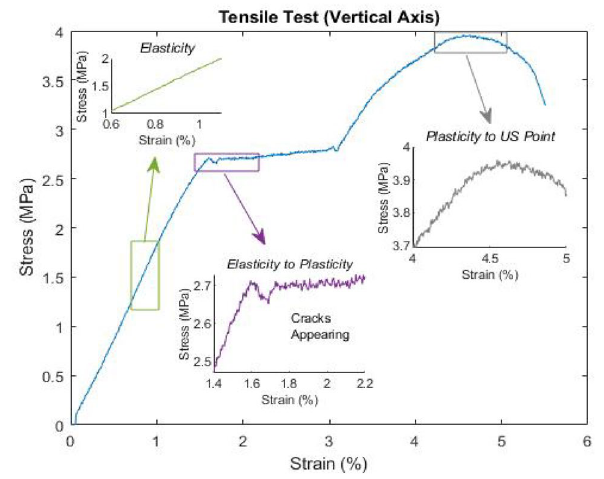
Fig. 16 Tensile strength of device in vertical axis